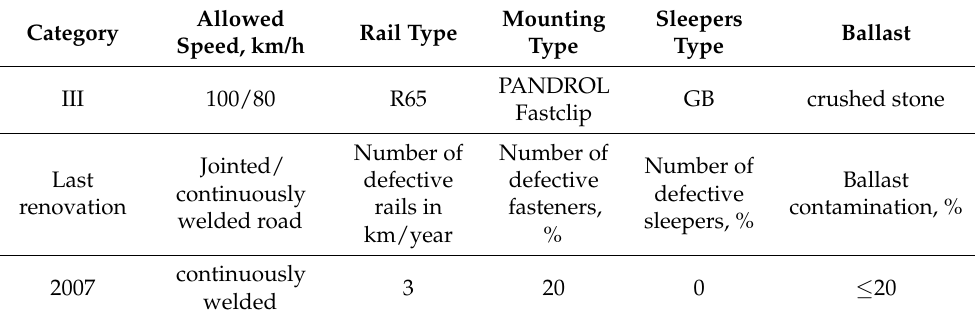
Table 1. Rail conditions.